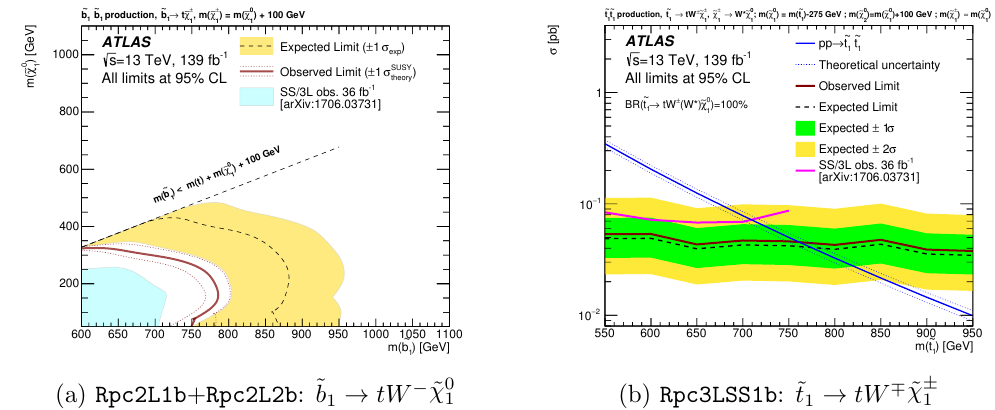
Figure 8. 95% CL exclusion limits on the production of pairs of third-generation squarks, assuming production cross-sections as in ref. [27] (for the left plot) and 100% branching ratios into the decay modes illustrated in (cid:12)gures 1(a) and 1(b) for the left and right plots, respectively. The limits are determined from the expected contributions of these processes to the Rpc2L1b and Rpc2L2b (left) and Rpc3LSS1b (right) SRs. The coloured bands display the (cid:6) 1 (cid:27) ranges (as well as (cid:6) 2 (cid:27) for the right (cid:12)gure) of the expected (cid:13)uctuations around the mean expected limit, in the absence of contributions from the sought-for signals. They do not account for uncertainties in the signal process cross-sections, the impact of which is illustrated by the dashed lines around the observed limits. The (cid:12)gures show for reference the reach of the previous analysis